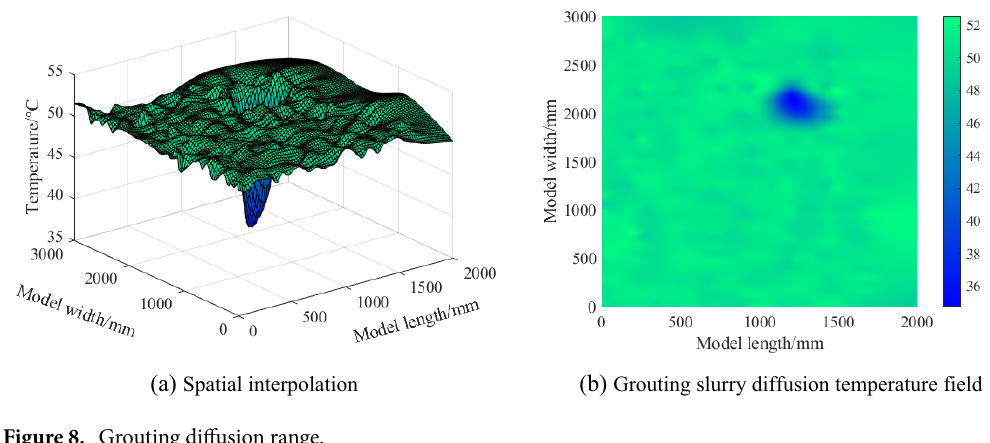
Figure 8. Grouting diffusion